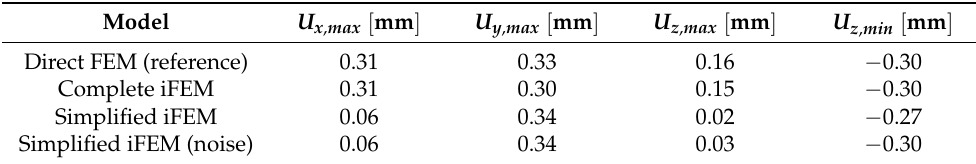
Table 5. Comparison between maximum displacement results.